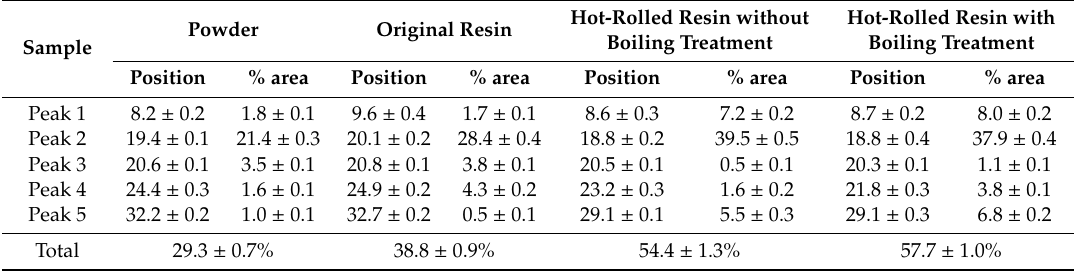
Figure 9. XRD spectra of (a) the RS powders, (b) the RS resins, (c) the RS hot-rolled resin without the boiling treatment, and (d) the RS hot-rolled resin with the boiling treatment. Table 6. Analysis peaks of XRD results of RS samples and their crystallinity percentage.